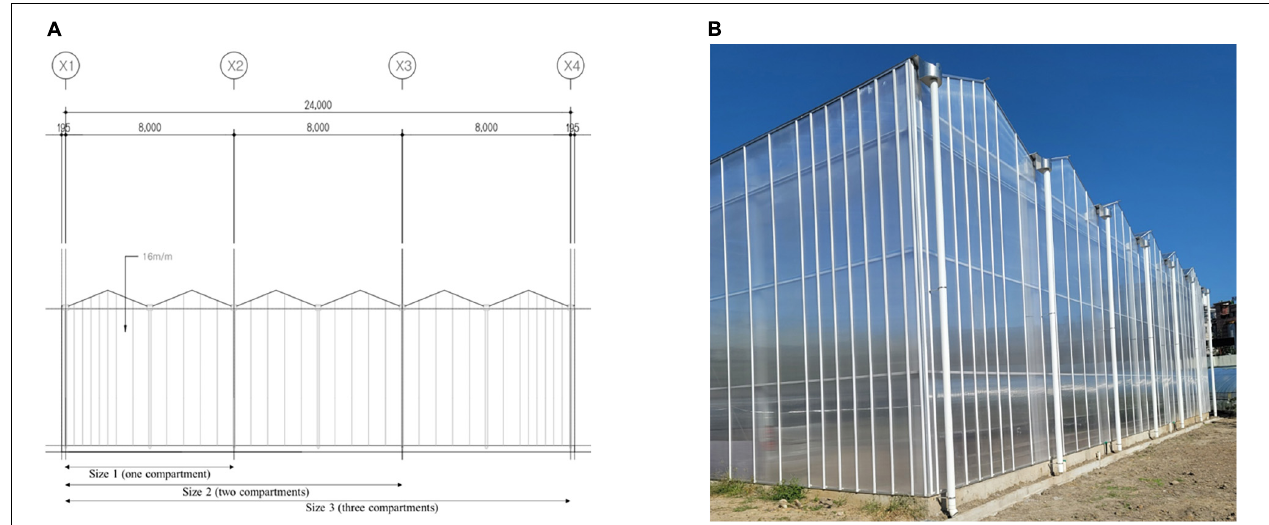
FIGURE 5 | Schematic of the experimental plant production system with one to three compartments (X1–X2: Size 1, X2–X3: Size 2, X3–X4: Size 3) (A) , and external view of the system (B) .